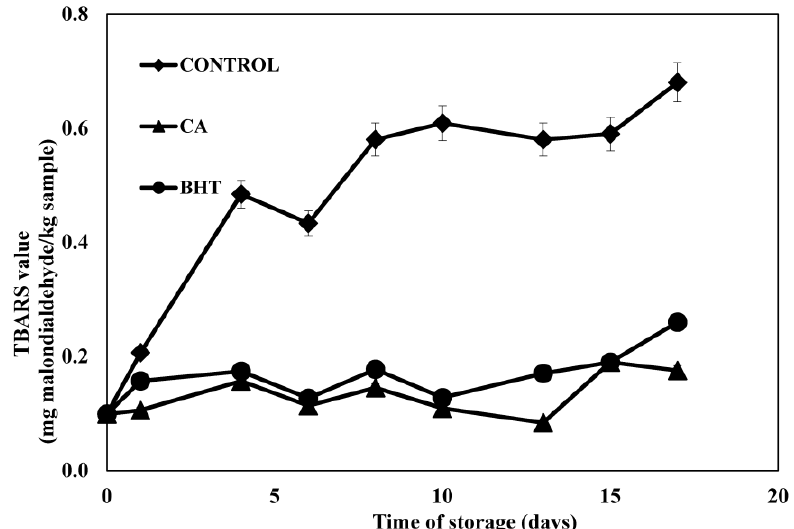
Figure 3. Changes in TBARS values (mg malondialdehyde/kg sample) of control and sample containing BHT and CA extract in MAP atmosphere during 17 days’ storage at 4 ± 1 °C without light. Each sample was measured in triplicate and the average standard deviation for each sample was less than